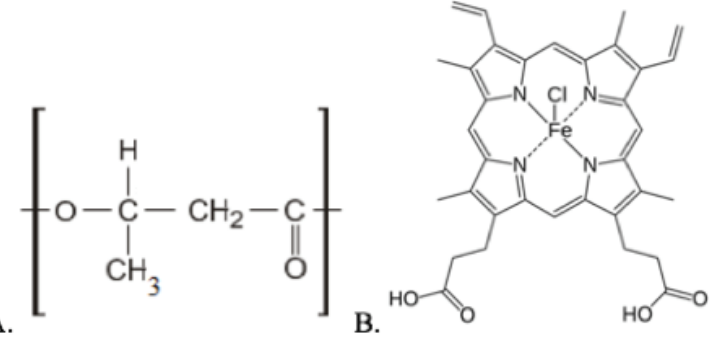
Figure 1. Structural formulae of PHB ( A ) and hemin ( B ).